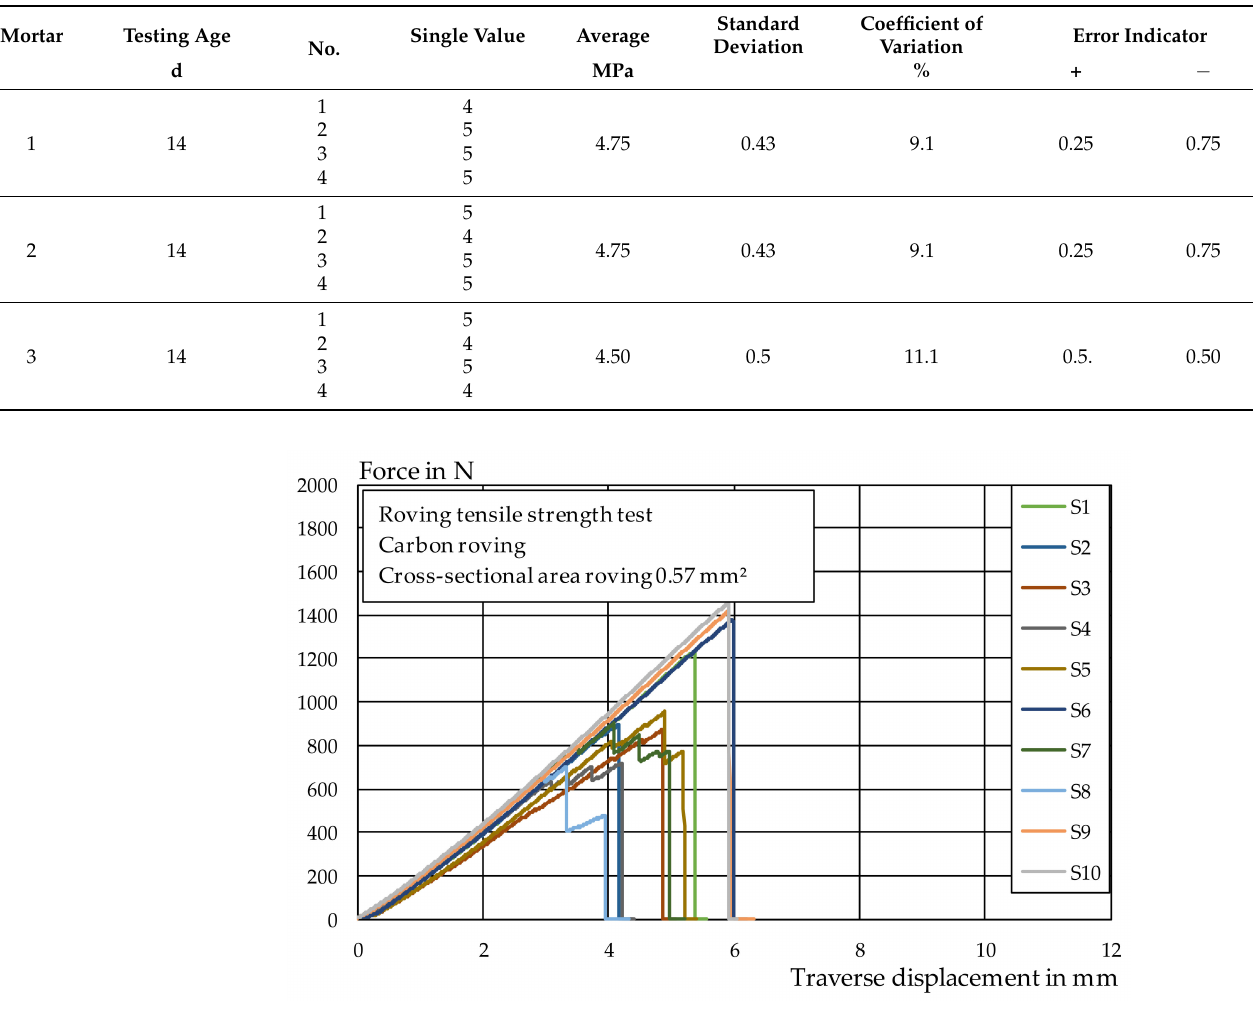
Figure A1. Roving tensile strength test, carbon roving.